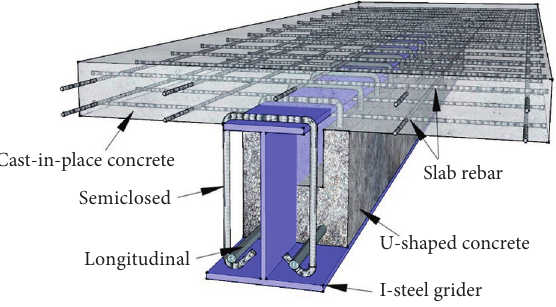
Figure 2: Schematic diagram of the